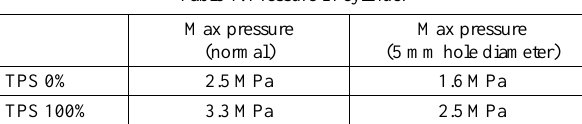
Fig. 8. Pressure curve in the combustion chamber with an orifice with a diameter of 5 mm for various throttle opening Table 1. Pressure in